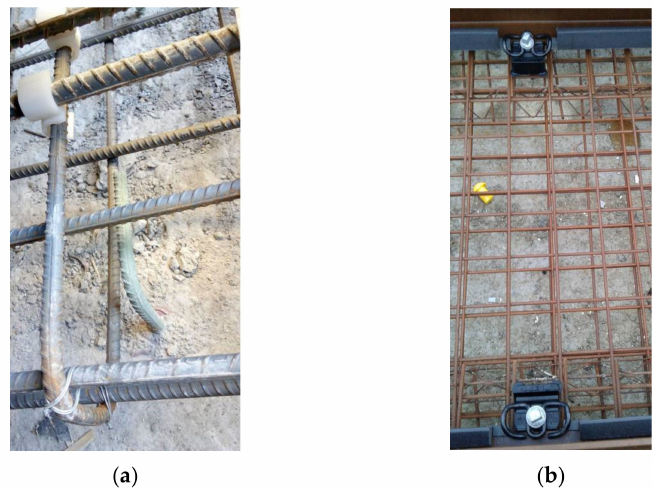
Figure 2. Details of stray current drainage using ( a ) rebars and ( b )